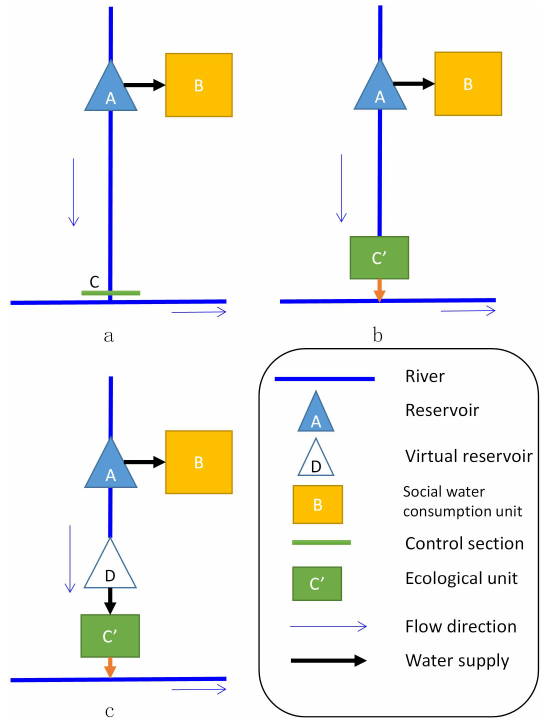
Figure 1. Water resource allocation network in E-WAS (Yan et al.,